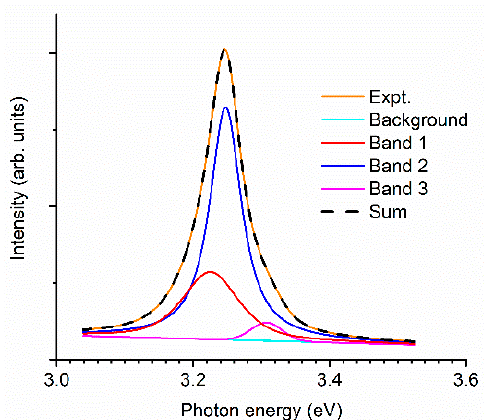
Figure 8. Photoluminescence emission intensity vs. photon energy showing resolved peaks for Q10 (1000 c. uncapped sample). The dashed line is the fitted peak. Table 6. Best-fit parameters of the Gaussian bands used in modelling the PL spectrum of Figure 8. Band